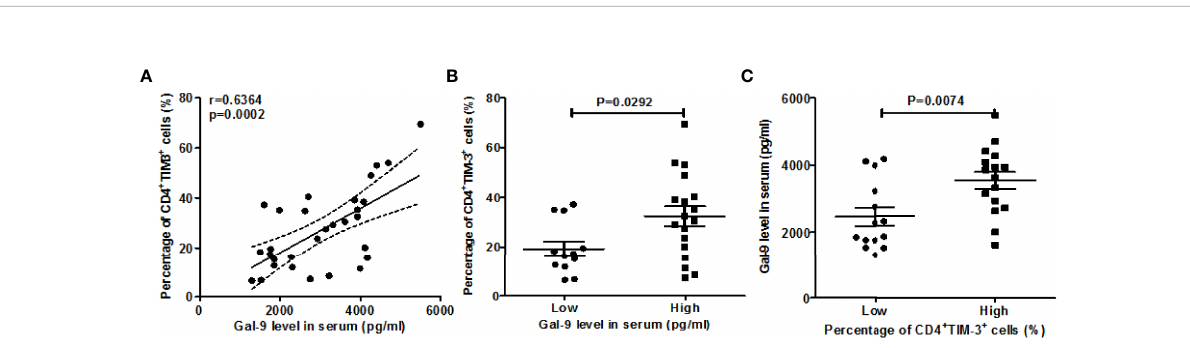
FIGURE 2 Correlation between Gal-9 levels and rates of TIM-3+CD4+ T cells. (A) Association between the percentage of TIM-3+CD4+ T cells and serum Gal-9 levels. For comparisons between groups, we divided the data based on Gal-9 level as low (<2659.13pg/ml), high ( ≥ 2659.13pg/m) and the frequency of TIM-3+ cells on CD4+ T cells as low (<21.9%), high ( ≥ 21.9%), respectively. The above cut-off values were 2 times the mean of HC test results. (B, C) The association of the serum Gal-9 level and the percentage of TIM-3+CD4+ T